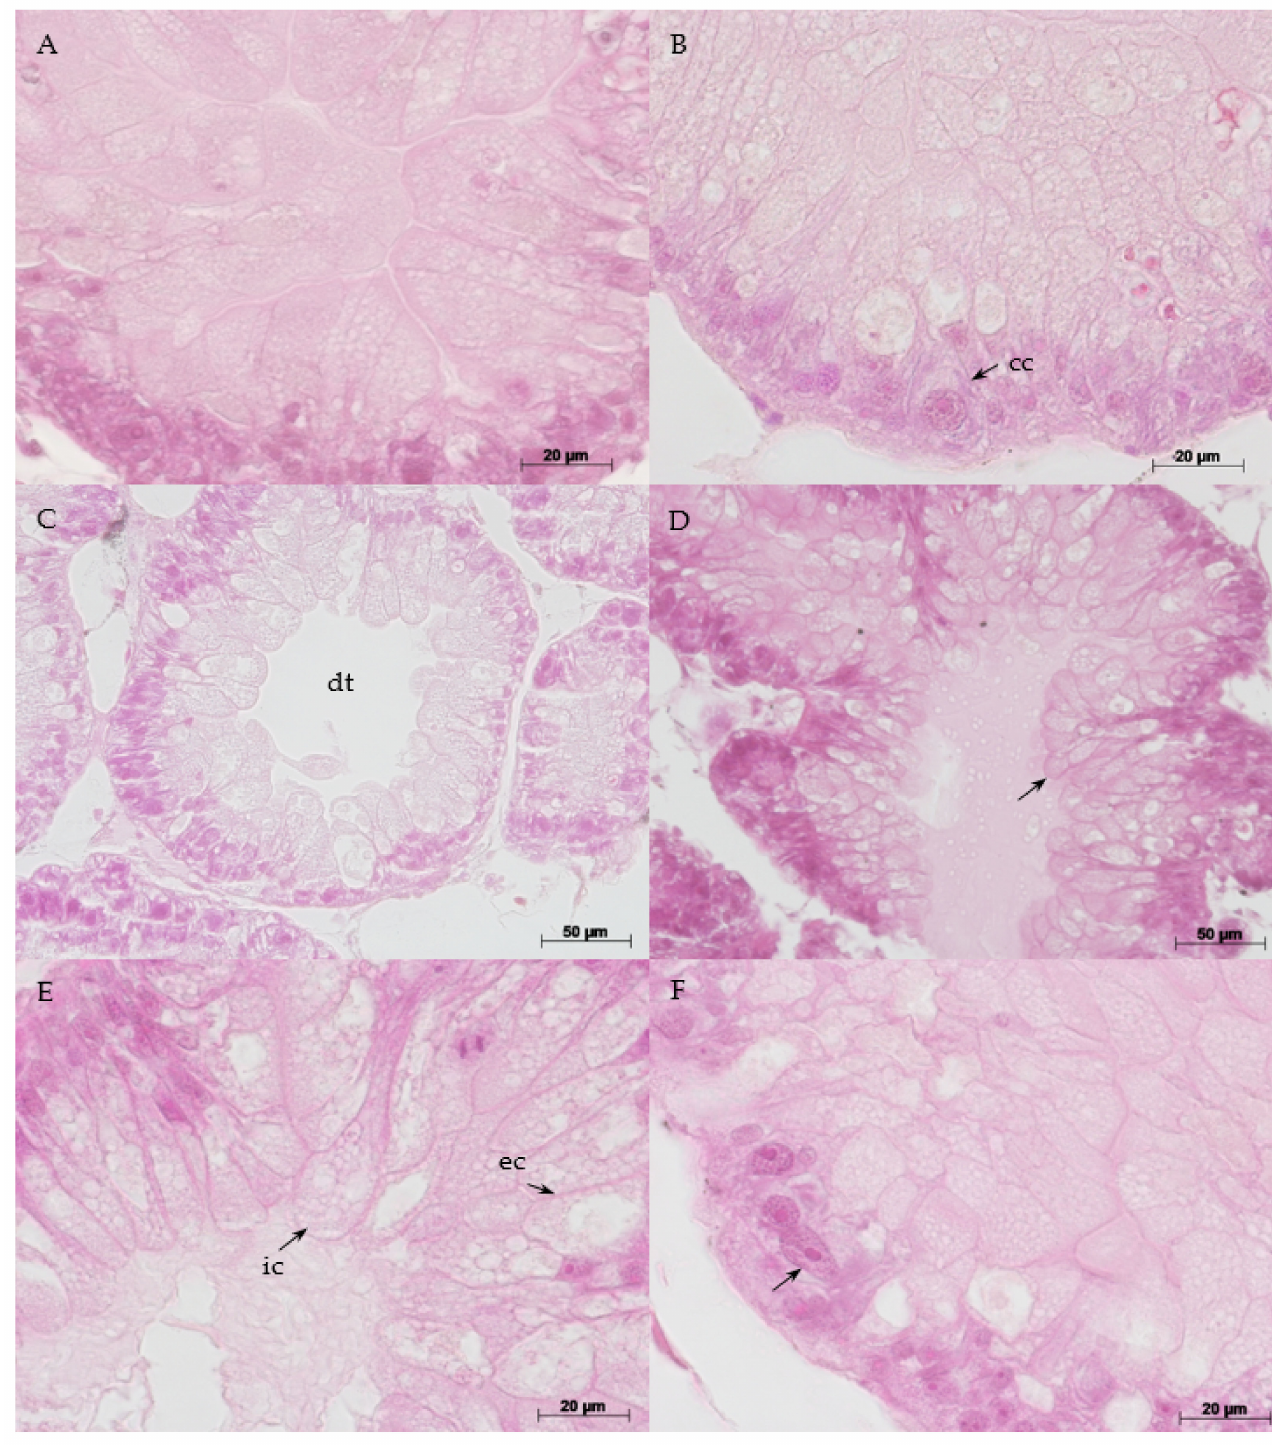
Figure 1. Histological status of the hepatopancreas of big ramshorn snail. All sections were stained with haematoxylin-eosin. ( A ): control status—narrow tubule lumen and digestive cells with regular compartmentation; ( B ): control status—crypt cell (cc) with round nucleus; ( C ): reaction status—dilated tubule (dt); ( D ): reaction status—slightly dilated tubule (dt) with irregular shaped apices of digestive cells and protrusion into the lumen (arrow); ( E ): reaction status—irregular compartmentation (ic) of digestive cell, excretory cell (ec); ( F ): reaction state—irregular shaped nucleus of crypt cell